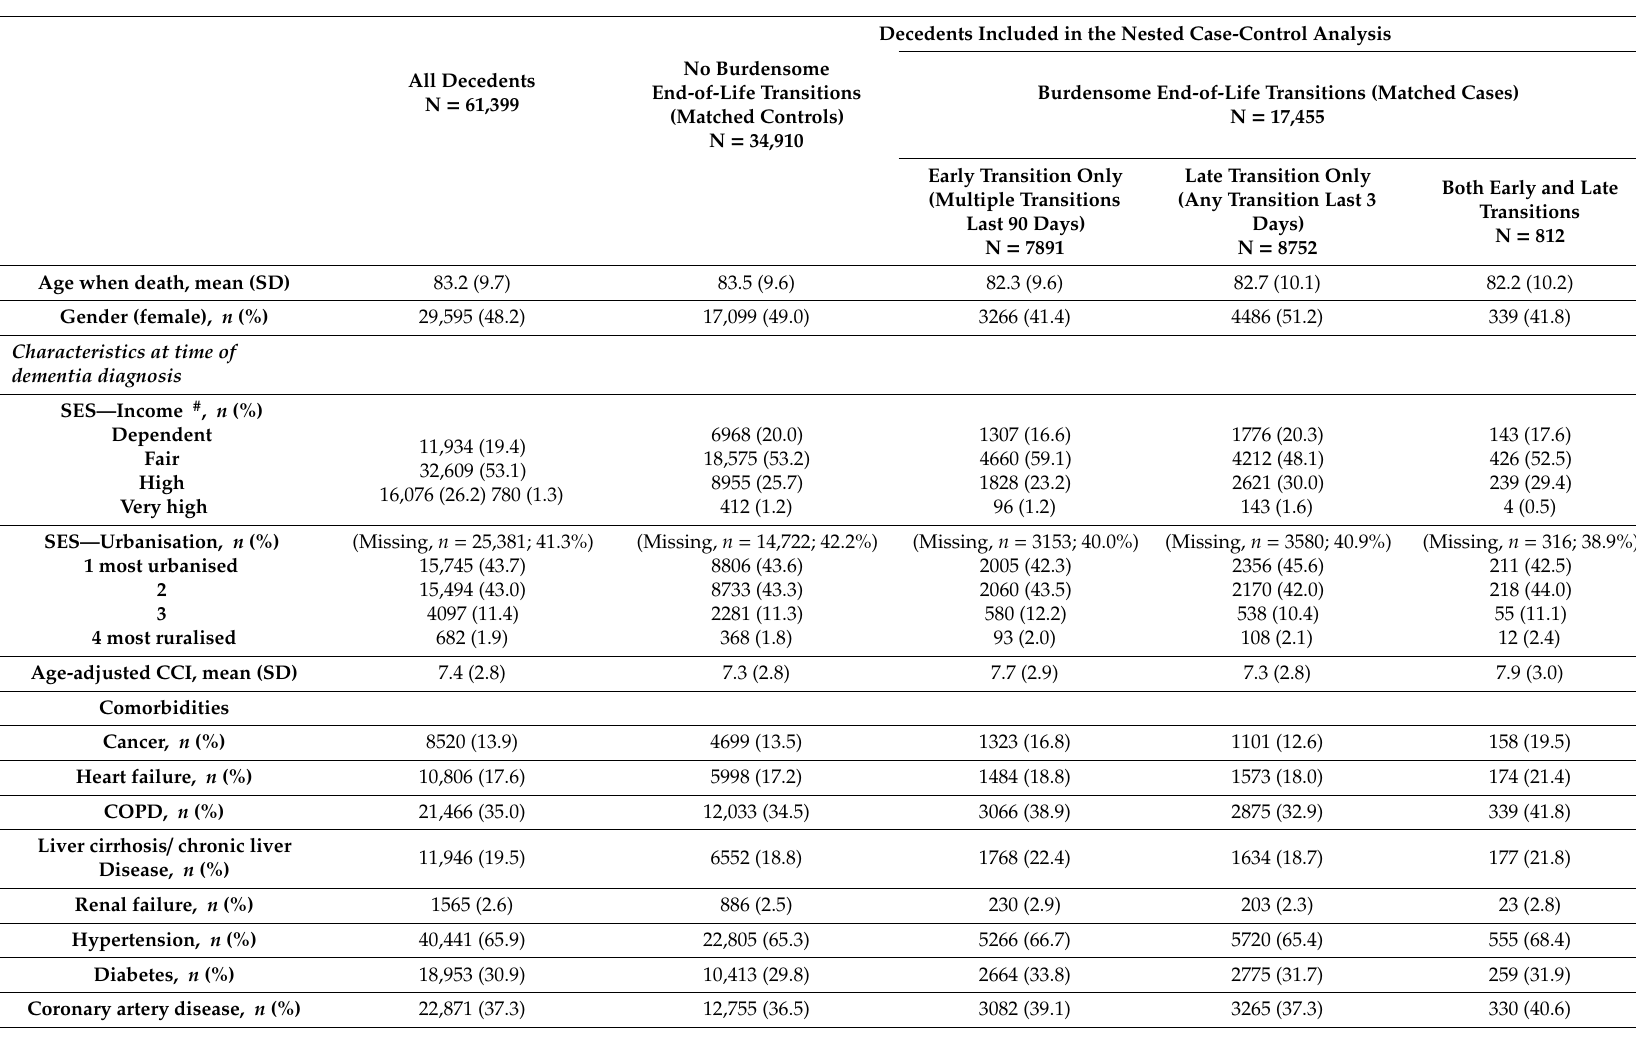
Table 1. Characteristics of people with dementia and matched groups with or without burdensome end-of-life